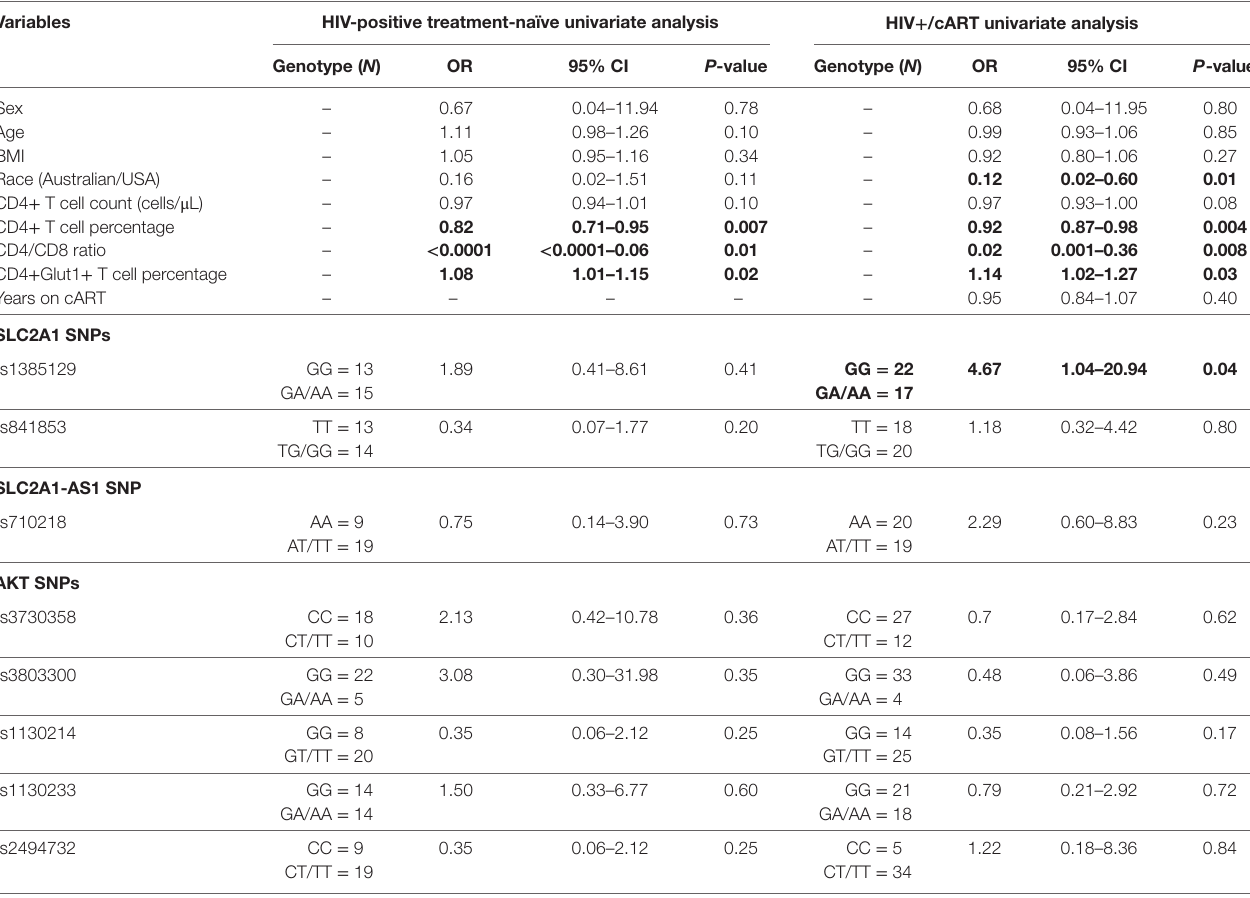
TaBle 2 | Univariate associations with disease progression among HIV-positive treatment-naïve individuals and response to therapy for HIV + /cART